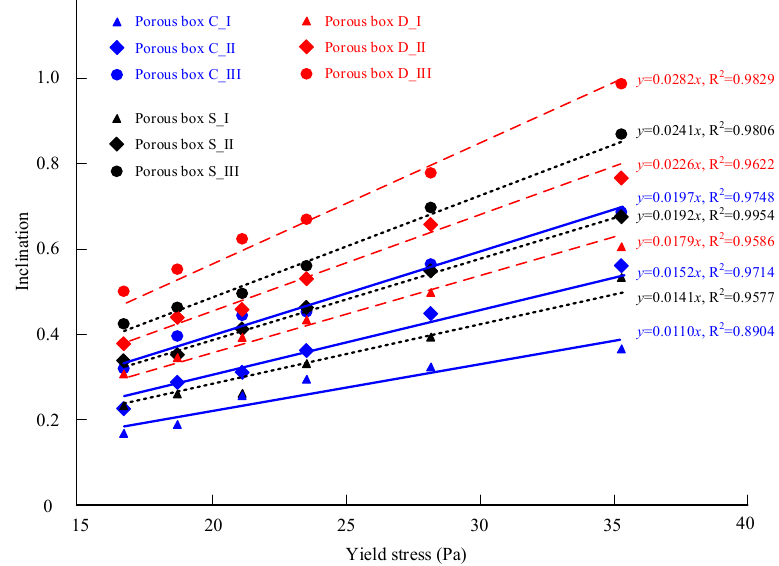
Figure 7. The inclination–yield stress relationship for the porous boxes.